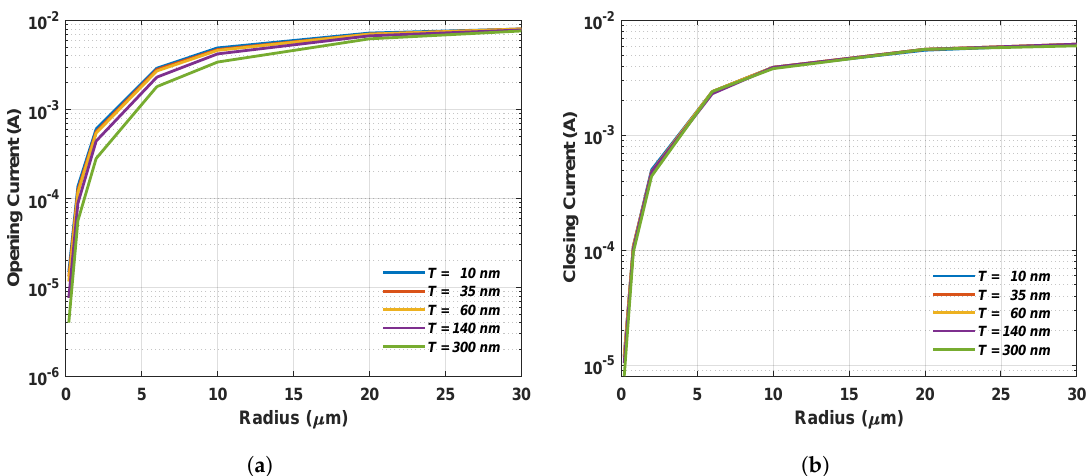
Figure 14. The dependence of the ( a ) opening and ( b ) closing currents on the radius of the VO 2 resistor. During the hysteresis domain, the resulting V-I curve also has hysteric nature (refer to Figure 9b). Maximum difference between the resistance of VO 2 resistor during heating and cooling phases is called the maximum switching resistance. It can be observed that the maximum switching resistance varies linearly versus thickness Figure 15a, in contrast, it has a nonlinear dependence on the radius Figure 15b.